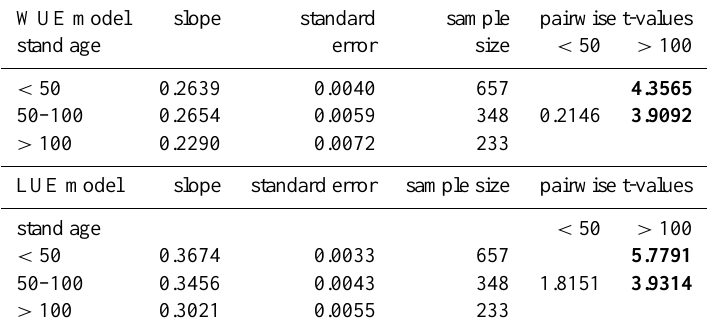
Table 3. Regression slopes of observed NPP against Level 1 WUE and LUE model predictors for three stand age classes, and t-values for all pairwise comparisons among the three classes (bold: P < 0 . 05 or